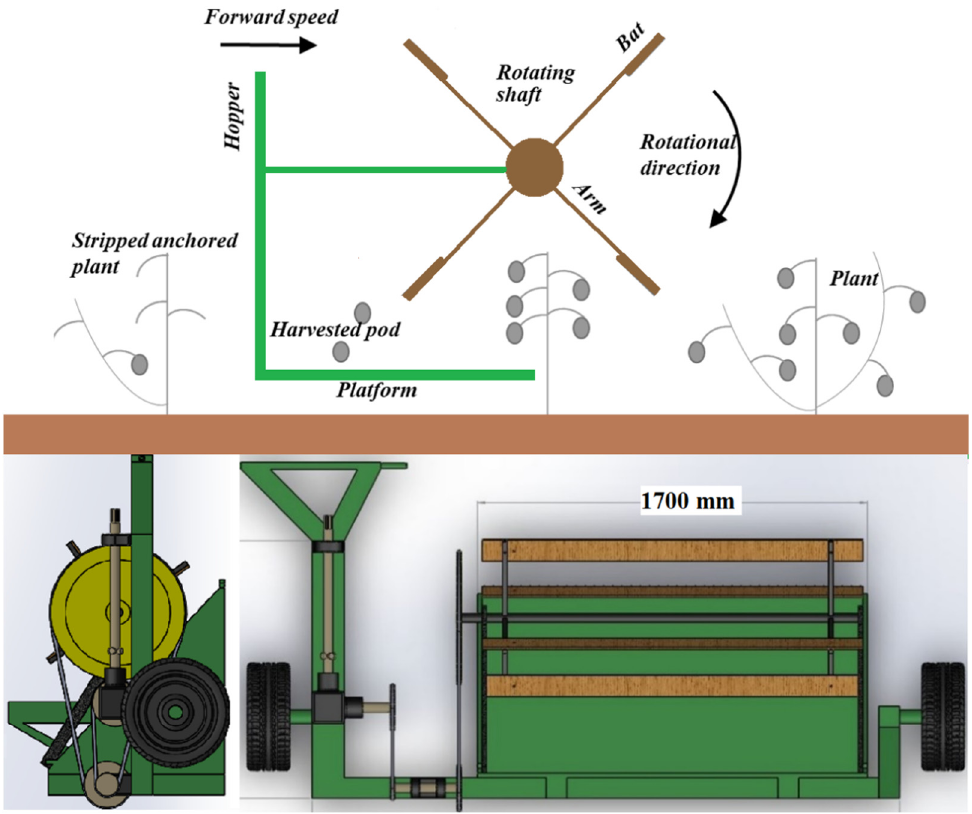
Figure 1. Schematic drawing of the main parts that comprise the proposed bat-type reel (up) and the chickpea harvester, Model 2017 (down). Table 1. Functional operators of the developed prototype chickpea harvesters and the field losses performed in harvesting tests.